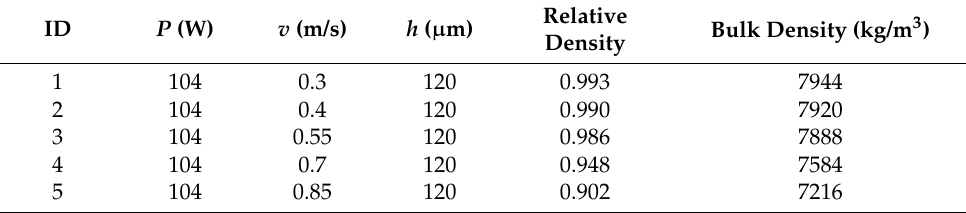
Table A7. Manufacturing parameters and experimental data adapted from [21]. Complement- ing relevant information and assumptions are the following; material: SS316L, theoretical